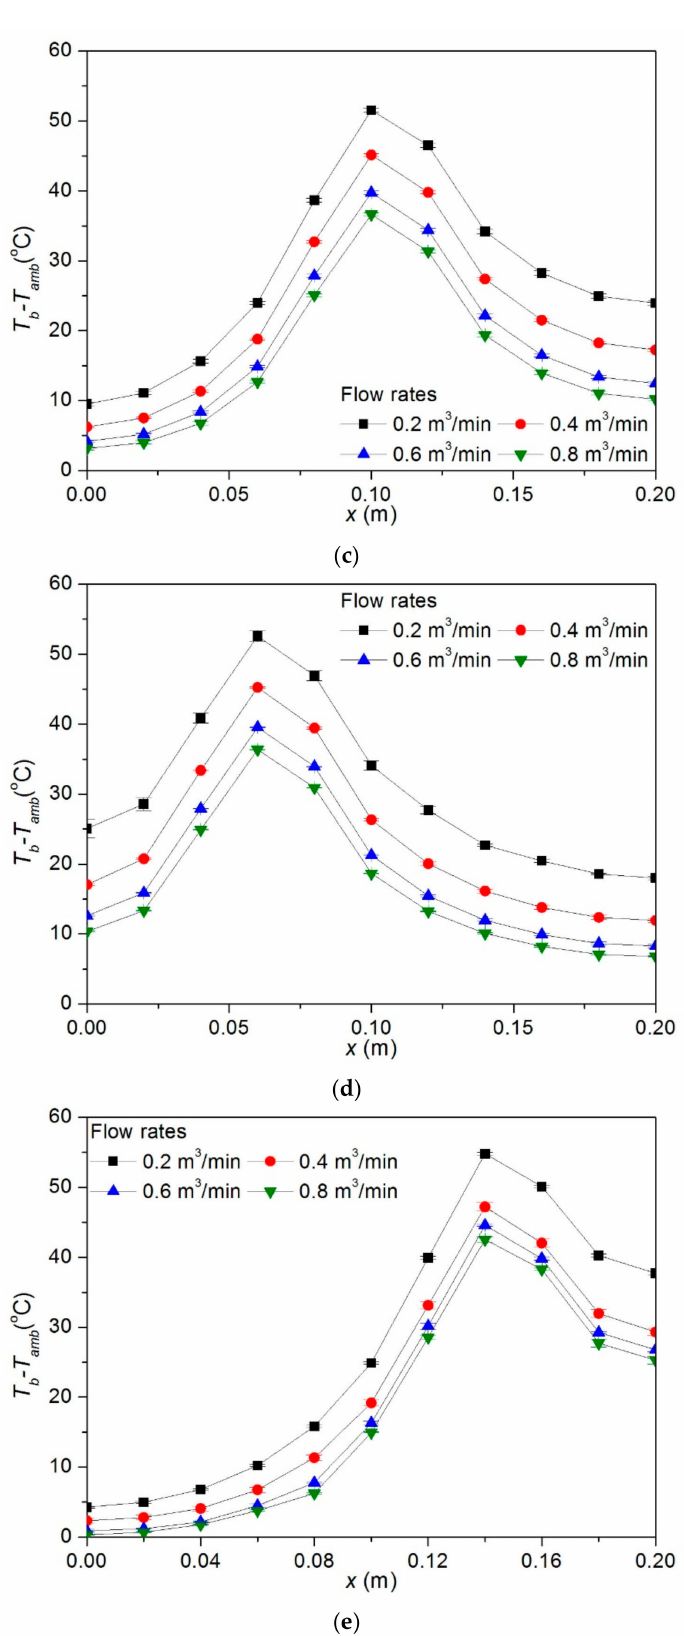
Figure 4. Profiles of di ff erence between base temperature and ambient temperature ( w c = 7 mm). ( a ) L h / L = 1.0, L c / L = 0.5; ( b ) L h / L = 0.6, L c / L = 0.5; ( c ) L h / L = 0.2, L c / L = 0.5; ( d ) L h / L = 0.2, L c / L = 0.3; and ( e ) L h / L = 0.2, L c / L =